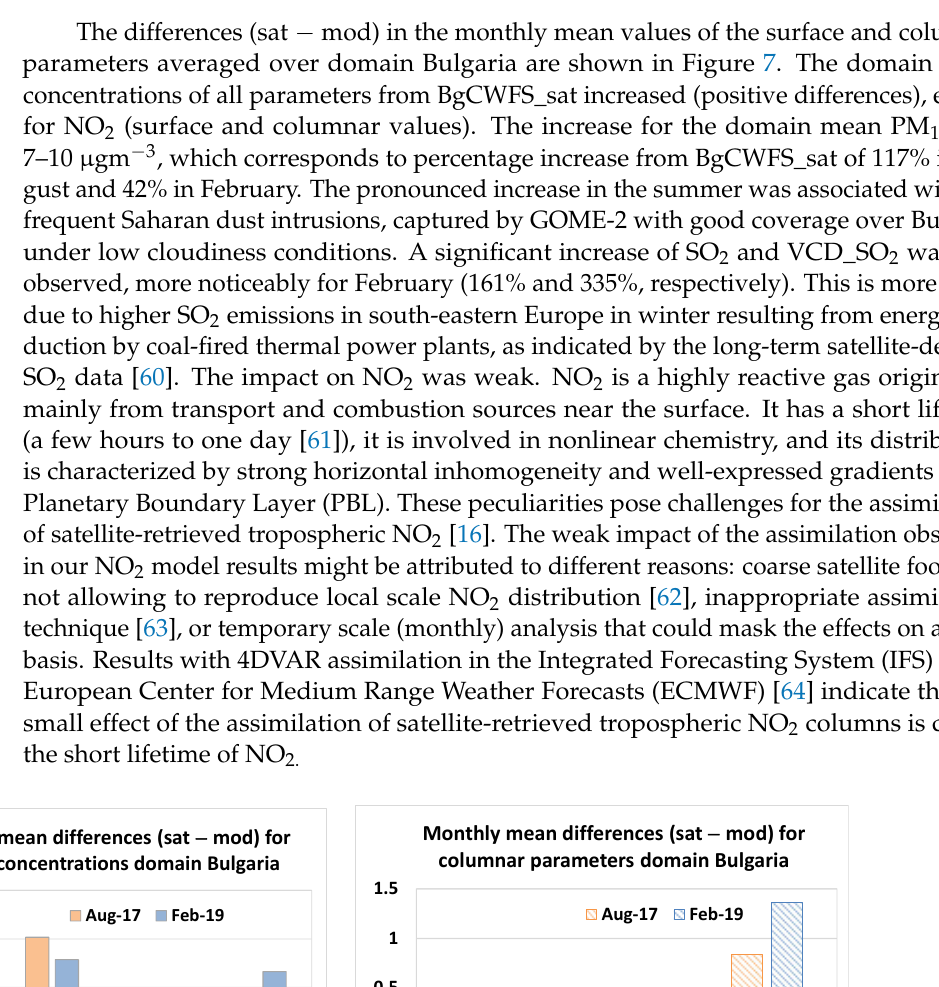
Table 1. Statistical parameters for BgCWFS results compared to surface observations in August 2017. August-2017